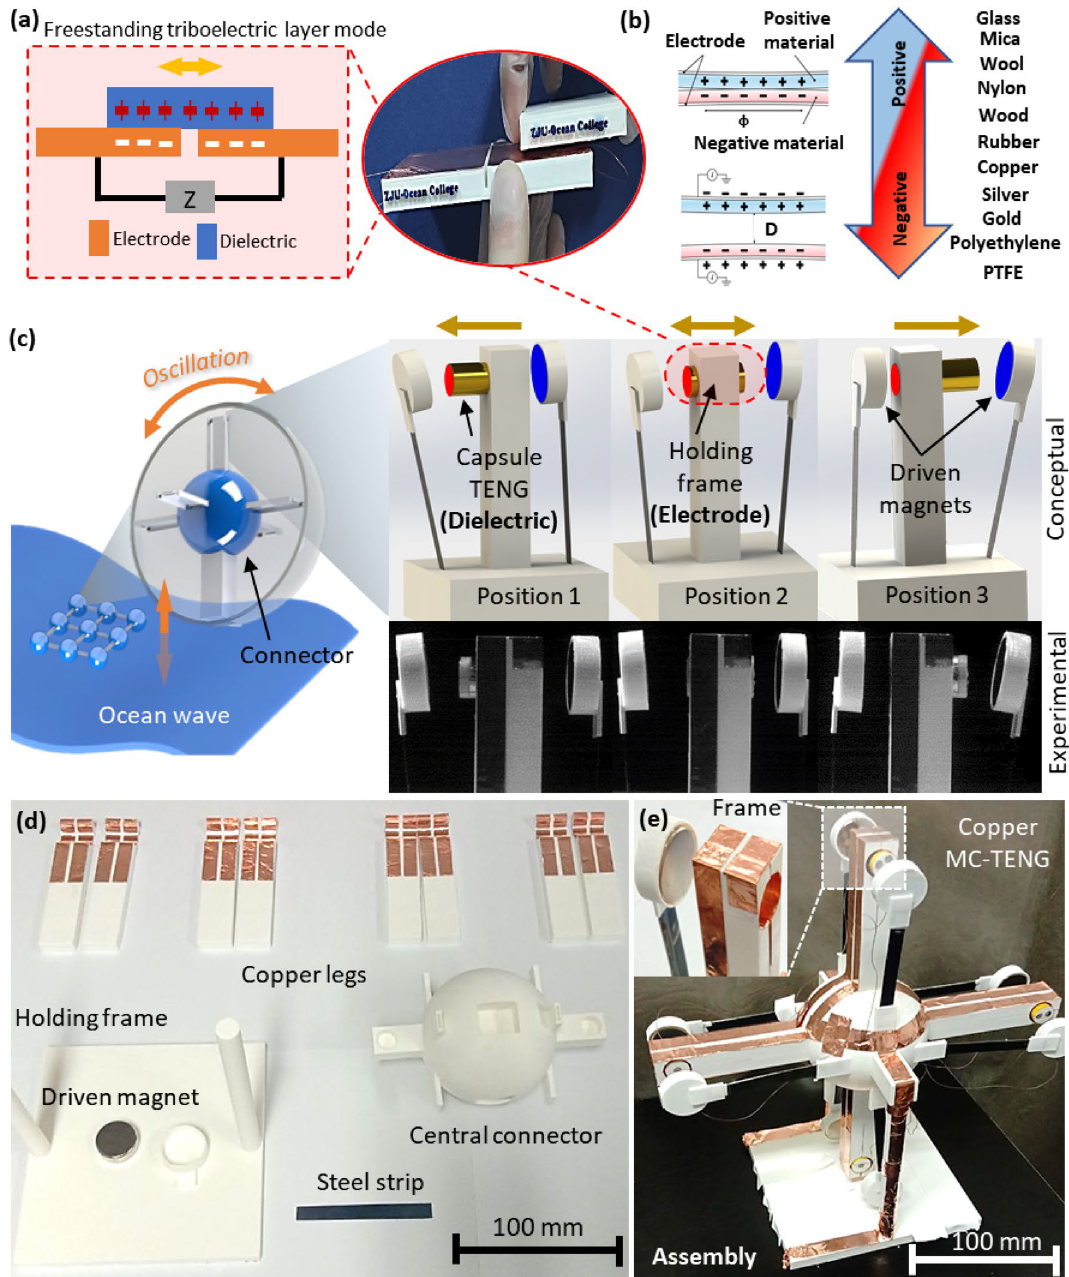
Figure 1. Design principle of the MC-TENG. ( a ) Principal illustration of the freestanding triboelectric layer mode used in the MC-TENG. ( b ) series of triboelectric material 40 . ( c ) Application of the MC-TENG in ocean wave, the three oscillation scenarios of the capsulate TENG (i.e., the dielectric) in the holding frame (i.e., the electrode) between the driven magnets, and the process comparison with the experimental observations recorded by a high-speed camera (conceptual images are created by SolidWorks 2017 SP4.1 https:// www. solid works. com/). ( d ) The components of the copper MC-TENG including the copper legs, holding frame, central connector, steel strips, and driven magnets. ( e ) Design details and assembly of the copper MC-TENG with four magnetic capsulate